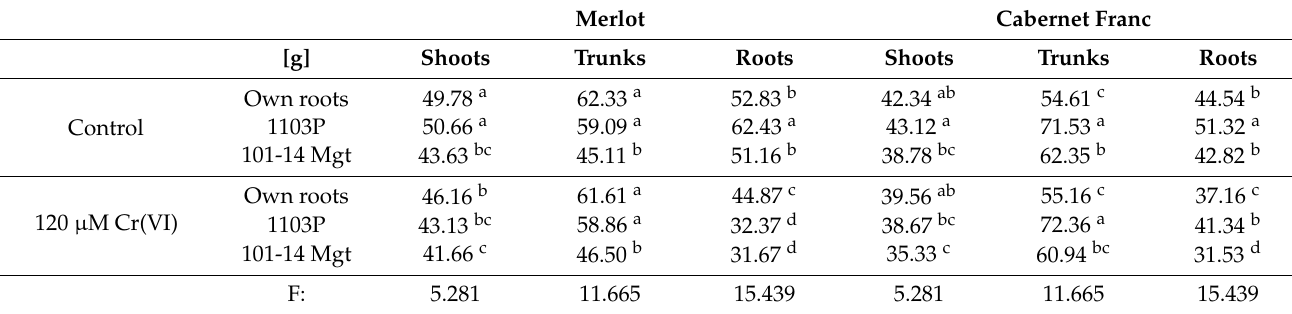
Table 1. The effect of Cr(VI) stress on shoot, trunk, and root dry weights of own-rooted Merlot and Cabernet Franc vine cultivars and vines grafted to 1103P and 101-14 Mgt rootstocks. Merlot Cabernet